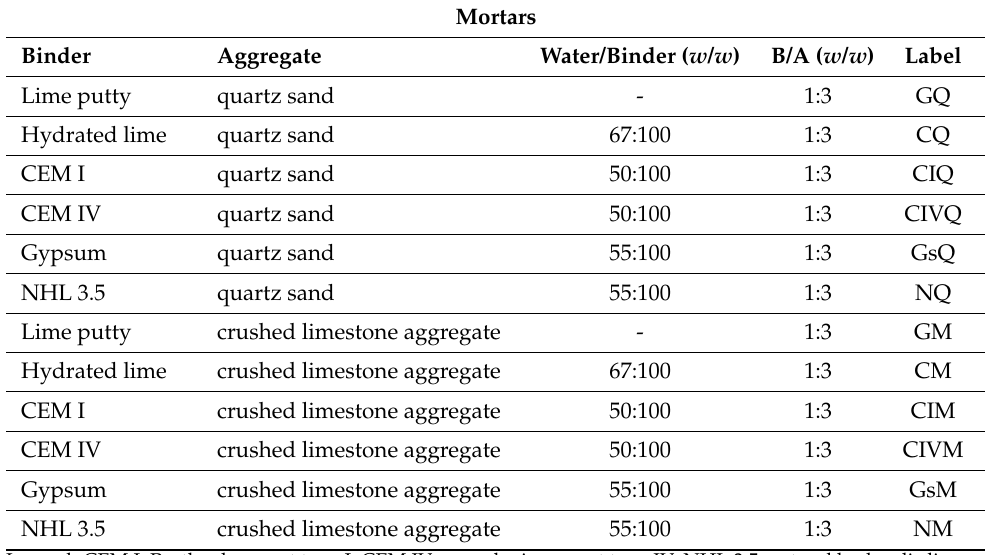
Table 1. List of the mortar mock